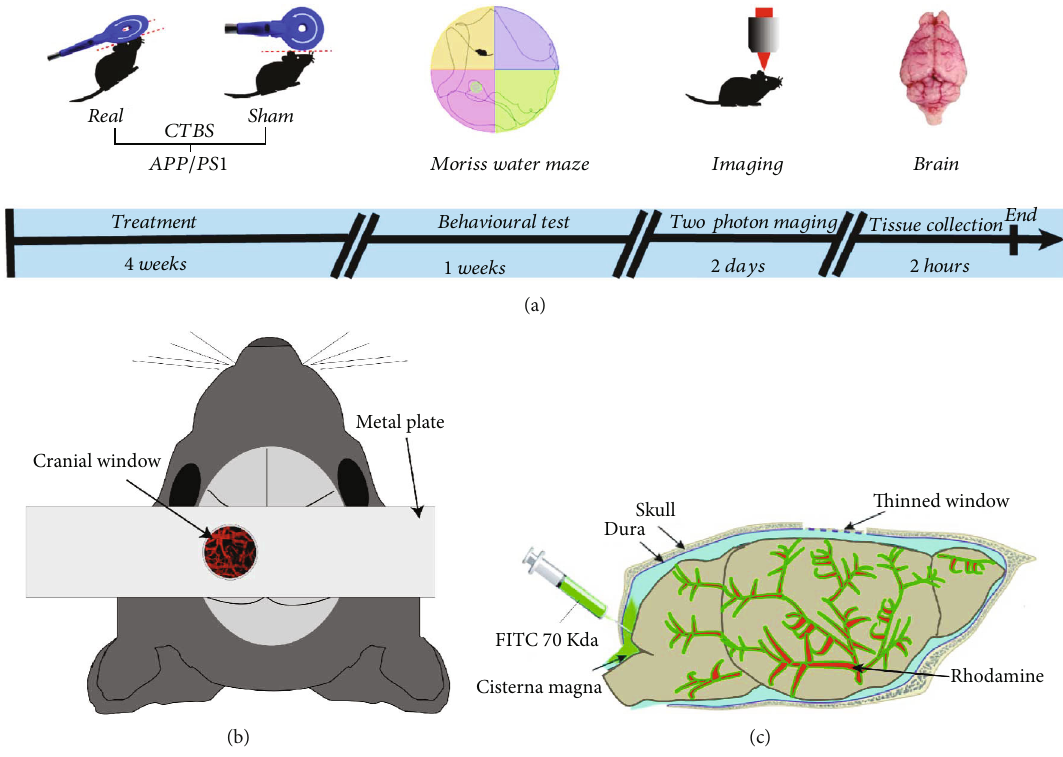
Figure 1: Study protocol. (a) Experimental timeline. Timeline showing a time series event of mouse treatment. APP/PS1 mice were fi rst subjected to continuous theta-burst stimulation (CTBS; Real, AR; Sham, AS) for four weeks, and then the spatial cognition function was tested in the Morris water maze (MWM). Two-photon imaging was used to detect the function of the glymphatic system within two days after the MWM was completed, and the sample tissue was collected within 2 hours after the imaging was completed. (b) A schematic diagram of the mouse cranial window. A thinned cranial window was prepared and fi xed on a metal plate. (c). Schematic diagram of Cisterna magna injection. After the cranial window was prepared, rhodamine was injected into the tail vein to label the blood vessels, and then FITC was injected through cisterna magna to prepare for